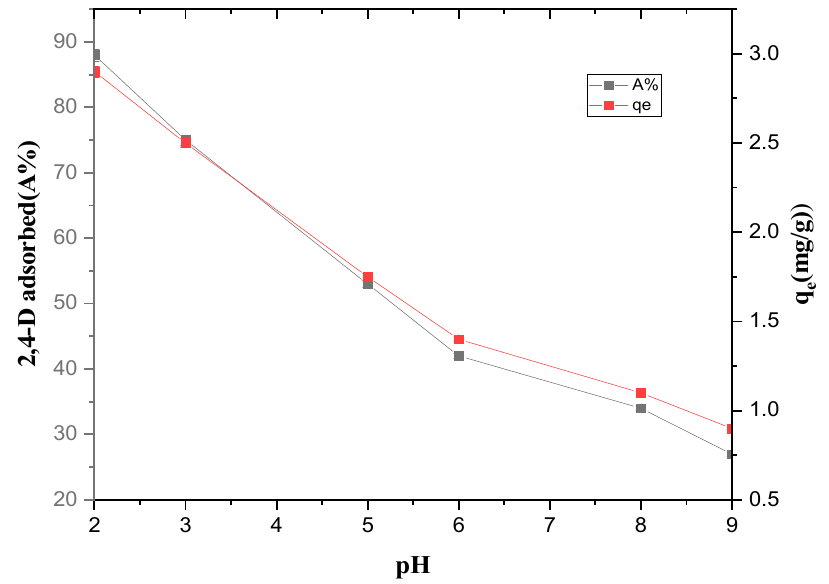
Figure 5. Effect of pH on 2,4-D percentage removal (A%) and adsorption capacity (q e ). The error bars show the standard deviation for three different sample runs.